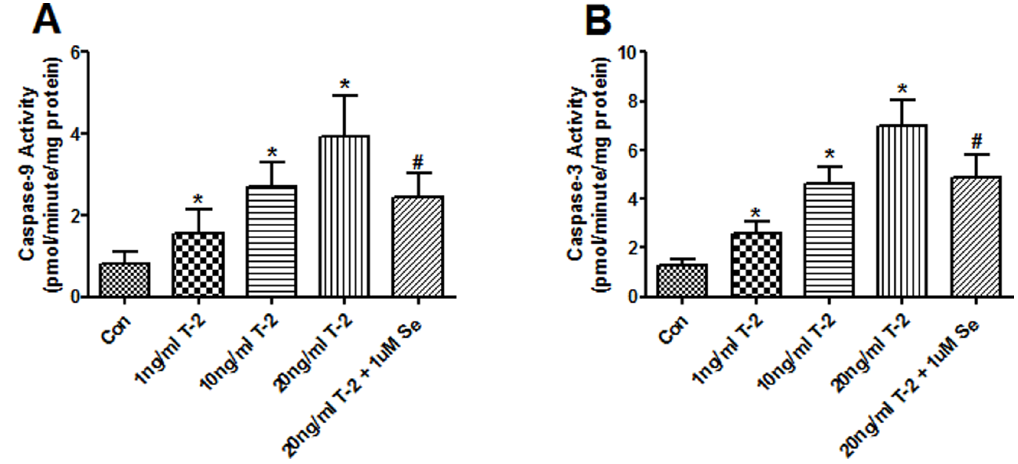
Figure 5. The effects of T-2 toxin on caspase-9 and caspase-3 activities in human chondrocytes. Cells were treated with 1, 10, 20 ng/ml T-2 toxin and 1 uM Na 2 SeO 3 + 20 ng/ml T-2 toxin for 5 d. The activities of caspase-9 ( A ) and caspase-3 ( B ) were measured using the substrate Ac- LEHD-pNA and Ac-DEVD-pNA, separately. * P , 0.05 vs. control; # P , 0.01 vs. 20 ng/ml T-2 toxin group.